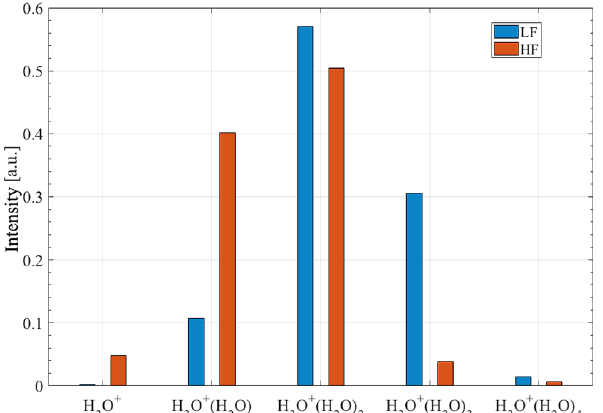
Figure 5. Comparison of the low-fragmenting (LF, voltage differ- ence: dV =− 1 . 4V) and the high-fragmenting (HF, voltage differ- ence: dV = − 10 . 0V) settings. Ion counts are corrected for trans- mission effects and normalised for each setting.